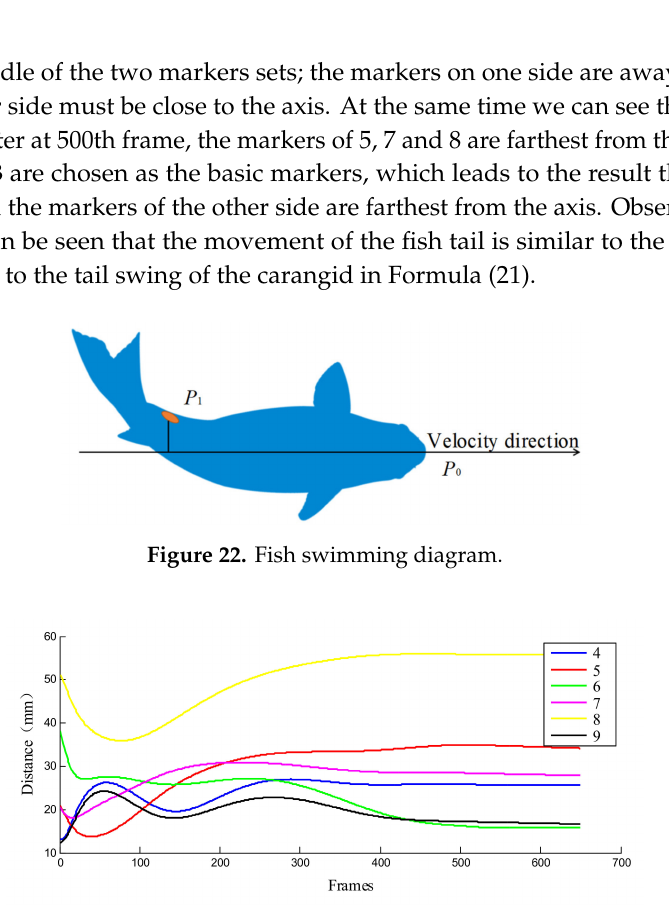
Figure 23. Distance between the markers and the axis.